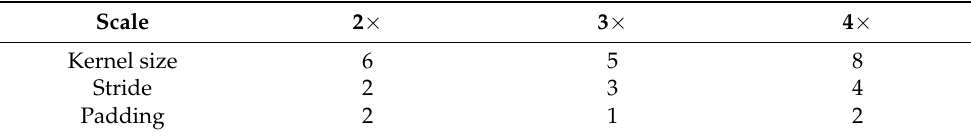
Table 1. Hyper parameters of the SR framework.